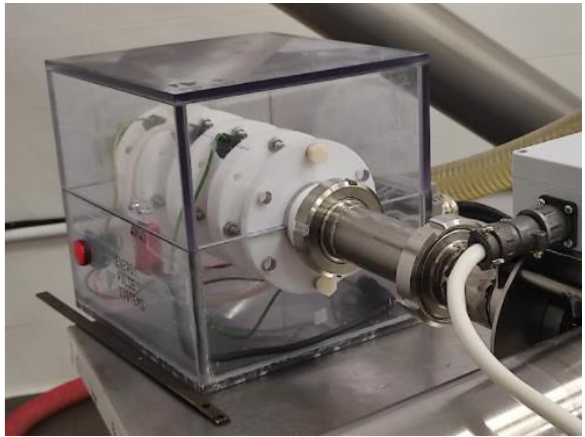
Figure 9. PEF unit by EnergyPulse Systems, Lisbon, Portugal.